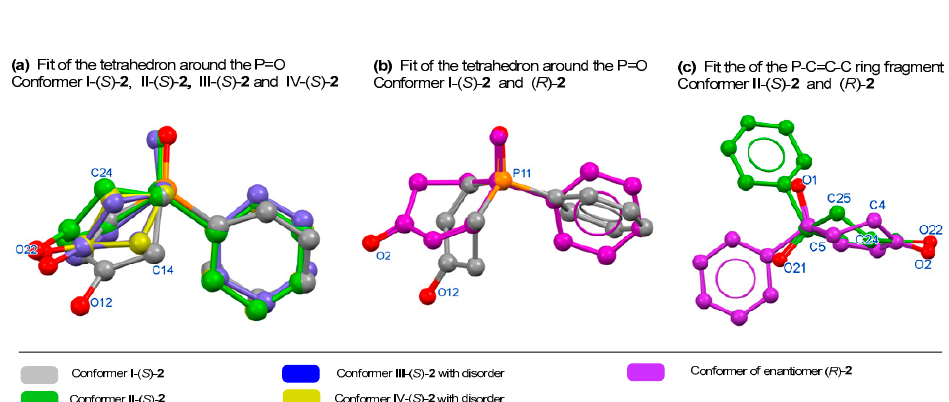
Figure 7. Molecular fitting of selected conformers. H-atoms are omitted for clarity. The geometric data for the phosphinenone ring in molecule ( R )- 2 indicate that it adopts a half-chair conformation with the P-phenyl group in the pseudoequatorial posi- tion (Figure 4c). A major conformational difference in the orientation of the phenyl ring is